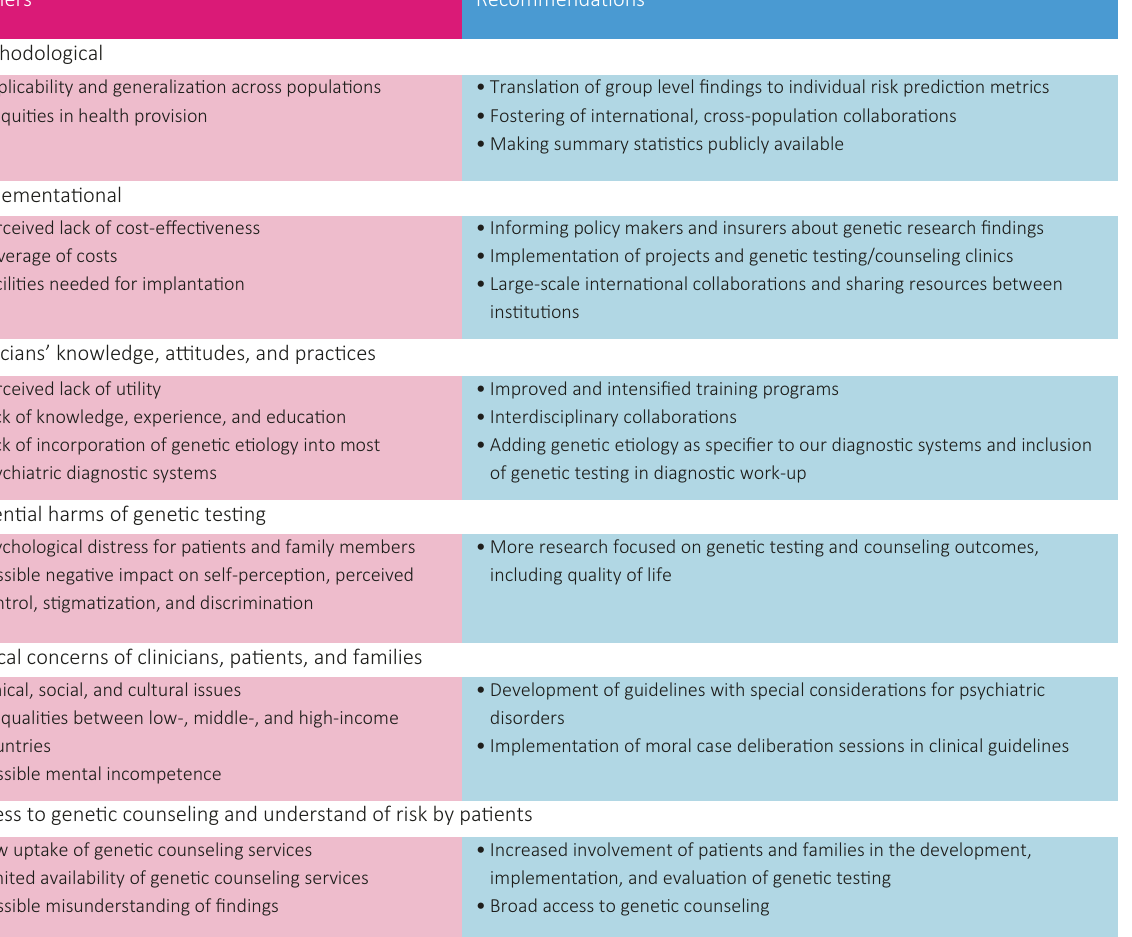
Fig. 1 Barriers to genetic testing in clinical psychiatry settings and recommendations on how to overcome them. The fi rst panel lists barriers as grouped in six different categories according to the nature of the barriers (i.e, methodological, implementational, etc.). In the same regard, recommendations are provided for each of the barrier